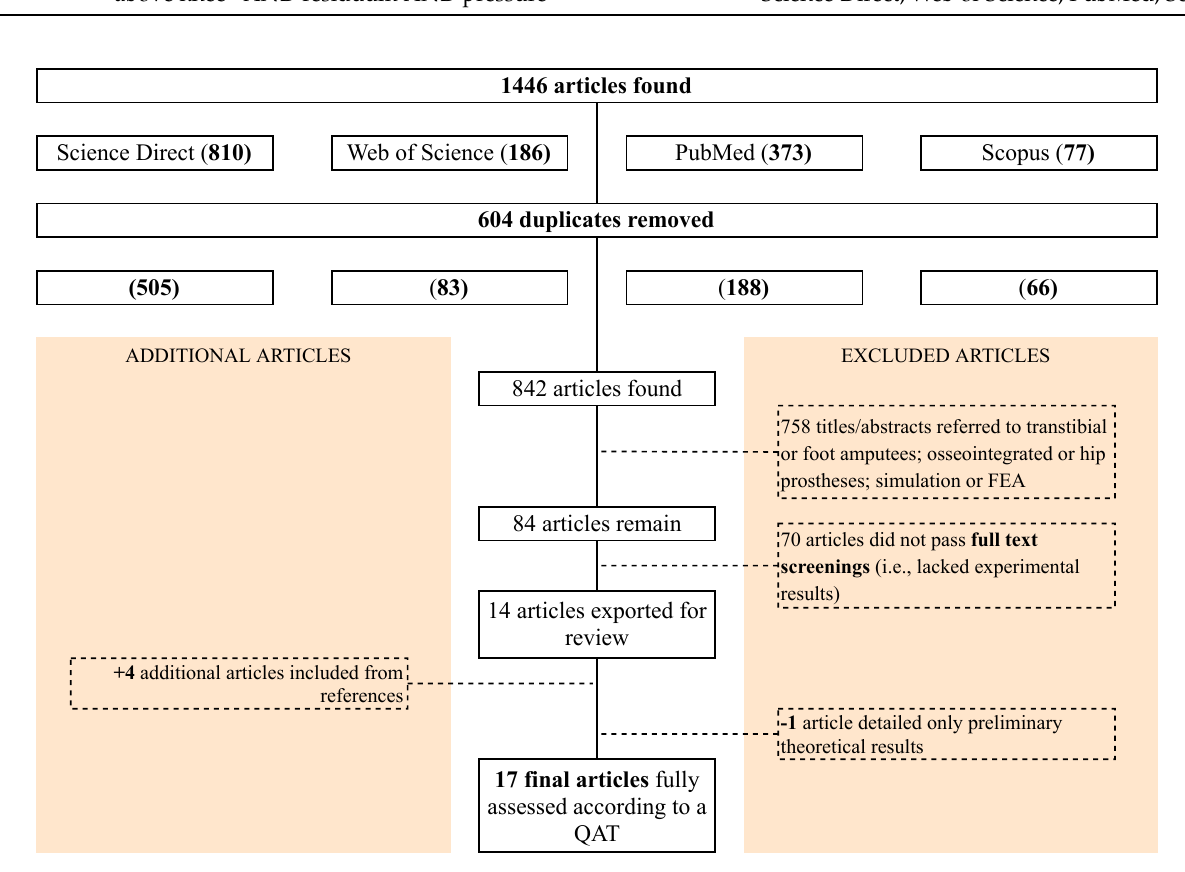
Figure 1. Flow diagram outlining